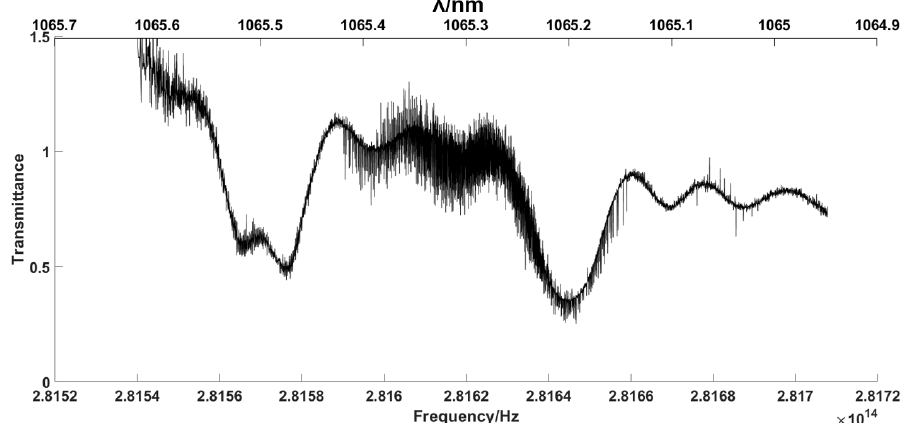
Figure 16. Experiment inversion from the RF domain to the OF domain.